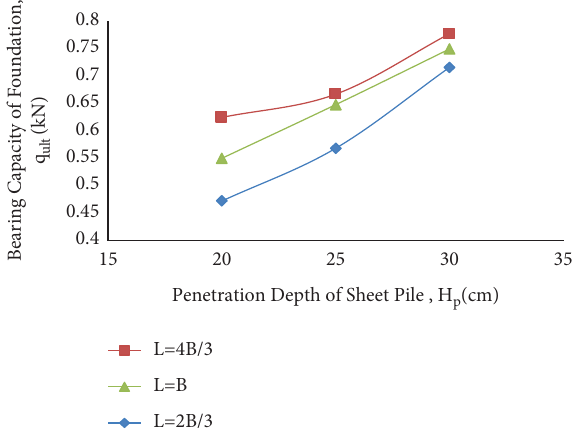
Figure 15: Change of q